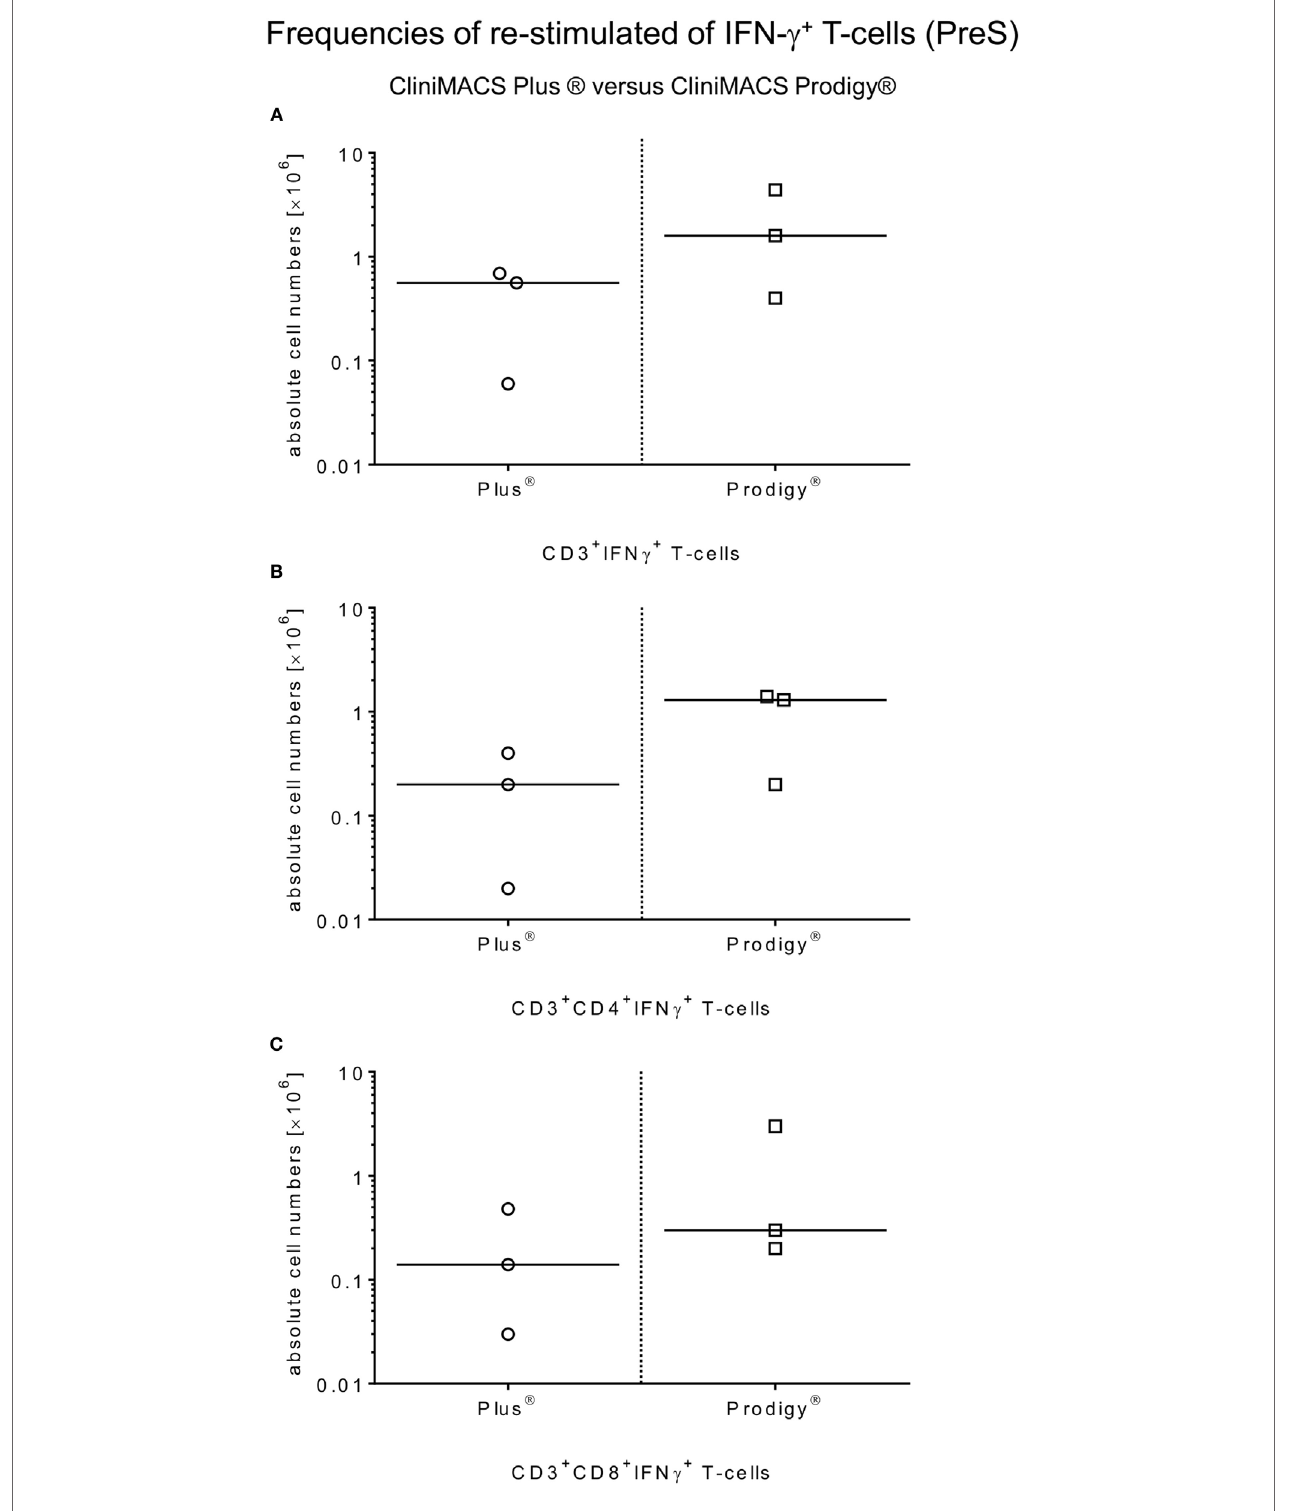
FIGURe 3 | Comparison of ex vivo restimulation of CMV-specific t-cells by antigenic restimulation by platform . Restimulation frequencies of CMV- specific T-cells were compared between all manufacturing processes of Plus and Prodigy. Samples were collected from the PreS fractions after incubation (4 h, 37°C, 5% CO 2 ) with the HCMVpp65 peptide pool (MACS GMP PepTivator HCMV pp65, 1 μ g/ml per peptide). Flow cytometric analyses were performed to identify total IFN- γ + -releasing CD3 + T-cells (A) and (CD4 + /CD8 + ) T-cell subsets (B,C) in those PreS fractions to compare both restimulation procedures.